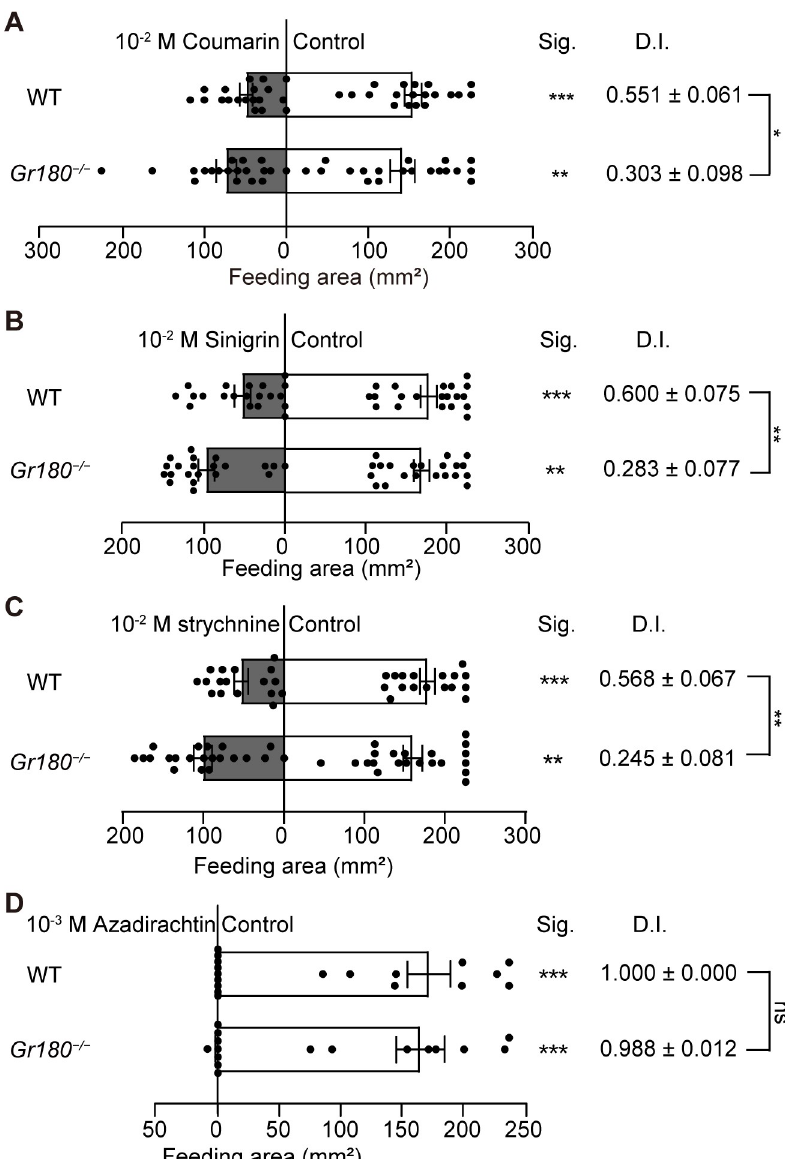
Fig 7. Feeding responses of Helicoverpa armigera wild type (WT) and Gr180 −/− mutant larvae to four deterrent compounds. (A) Control vs 10 − 2 M coumarin (WT: n = 19; Gr180 −/− : n = 19). (B) Control vs 10 − 2 M sinigrin (WT: n = 20; Gr180 −/− : n = 21). (C) Control vs 10 − 2 M strychnine (WT: n = 17; Gr180 −/− : n = 21). (D) Control vs 10 − 3 M azadirachtin (WT: n = 9; Gr180 −/− : n = 8). Data are mean ± SEM. �� and ��� indicate significant difference at the level of p < 0.01 and p < 0.001, respectively; ns indicates no significant difference (p > 0.05).